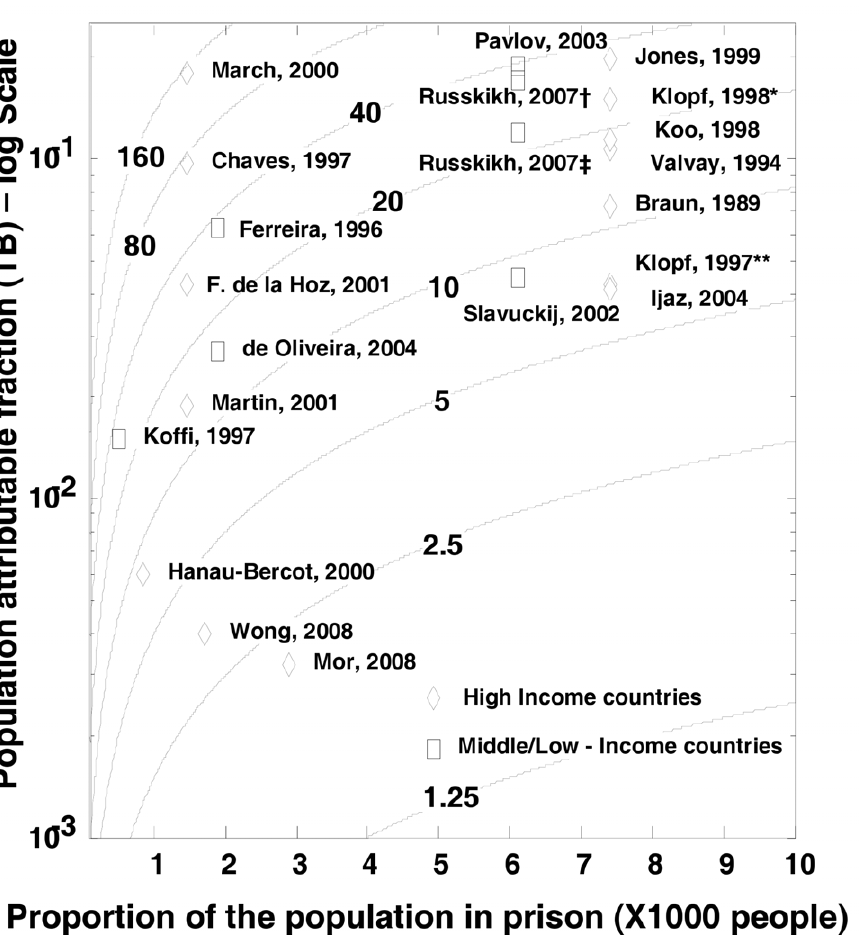
Figure 4. Contour plot showing the relationship between the proportion of exposed population, IRR, and PAF%. X-axis reports the proportion of the population in prison, Y-axis reports the PAF on a log scale calculated using the Levin’s formula [9]. The isoclines represent different levels of IRR. Klopf et al. reported TB incidence *before and **after implementation of a TB control program in New York State Department of Correctional Services and prisons personnel separately.[21] Russkikh et al. reported TB incidence among prison personnel { during and { following